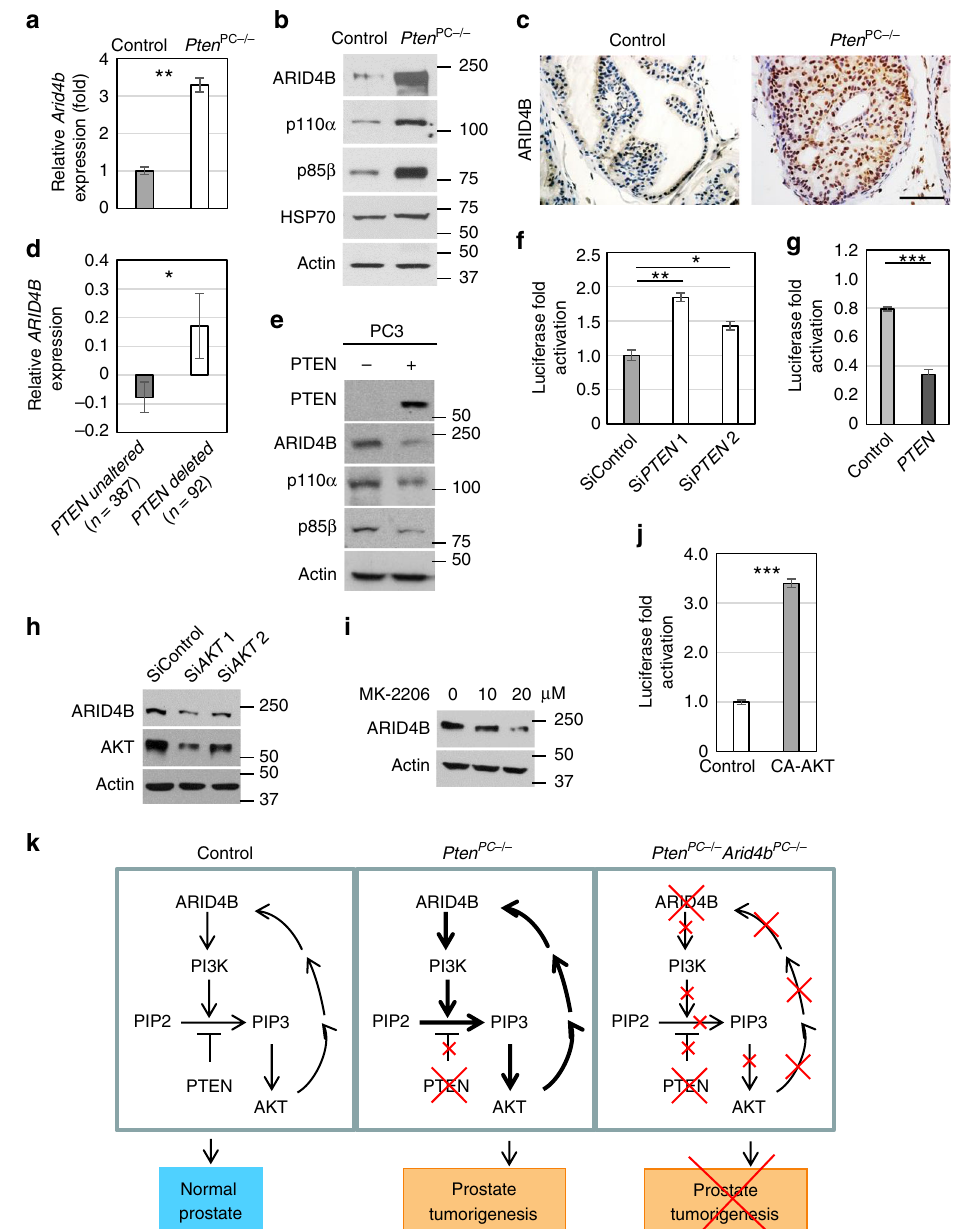
Fig. 5 PTEN de fi ciency increases expression of ARID4B via an AKT-ARID4B feedback loop. a Levels of Arid4b mRNA in anterior prostate from 3-month-old control and Pten PC − / − mice were measured by qRT-PCR analysis. b , c Levels of ARID4B, p110 α , p85 β , HSP70, and actin in control and Pten PC − / − anterior prostate at 3 months of age were determined by western blot analysis ( b ) or immunohistochemical staining ( c ). Scale bar, 50 μ m. d Relative ARID4B expression levels in human prostate cancers with unaltered or deleted PTEN from the TCGA dataset (provisional). Data are means ± SEM. e Levels of PTEN, ARID4B, p110 α , p85 β , and actin in PC3 cells with or without PTEN re-expression were determined by western blot analysis. f , g Luciferase reporter assays using the ARID4B promoter-driven luciferase reporter were performed in DU145 cells with or without knockdown of PTEN by two different short interfering RNAs Si PTEN 1 or Si PTEN 2 ( f ), and in HeLa cells with or without PTEN overexpression ( g ). h , i Western blot analyses determined the levels of ARID4B and AKT in PC3 cells with or without knockdown of AKT by short interfering RNAs Si AKT 1 or Si AKT 2 ( h ), or in PC3 cells untreated or treated with an AKT inhibitor MK-2206 ( i ). j Luciferase reporter assay using the ARID4B promoter-driven luciferase reporter was performed in HeLa cells with or without overexpression of CA-AKT (constitutively active AKT). Data are means ± SEM from three experiments performed in triplicate ( a , f , g , j ). * P < 0.05; ** P < 0.01; *** P < 0.001; Statistical analysis: t test ( a , d , f , g , j ). k Genetically engineered mouse models demonstrate that ARID4B is a key factor in the PTEN/ PI3K pathway to promote tumorigenesis in prostate with PTEN de fi ciency. In normal prostate (left), PTEN opposes the PI3K/AKT signaling pathway and constrains prostate tumorigenesis. In Pten PC − / − mice (middle), PTEN ablation results in activation of the PI3K/AKT pathway and the AKT-ARID4B positive feedback loop, leading to prostate tumorigenesis. In Pten PC − / − Arid4B PC − / − mice (right), knockout of ARID4B suppresses PI3K expression to compromise activation of the PI3K/AKT pathway, thus preventing prostate tumorigenesis elicited by PTEN de fi